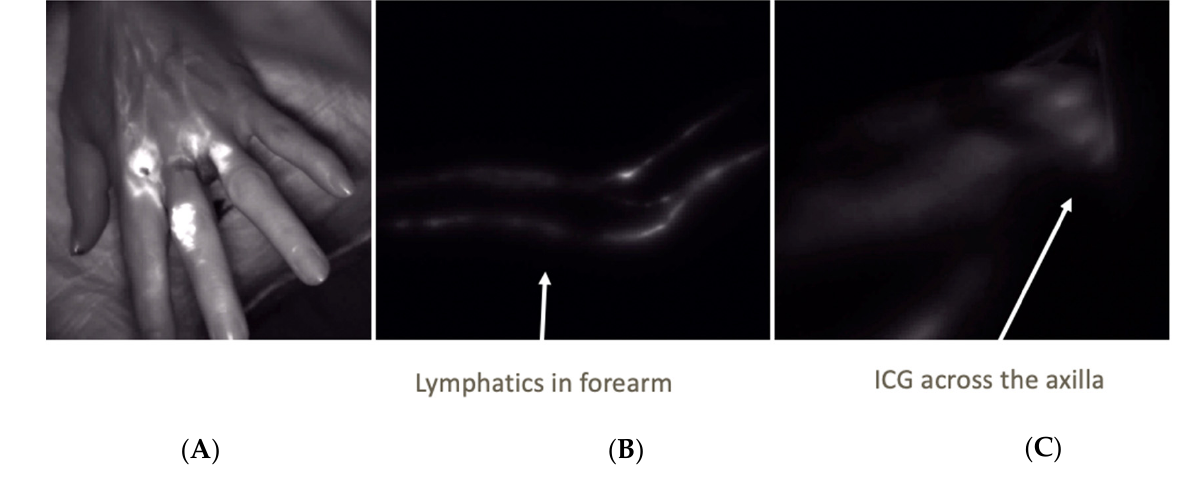
Figure 5. Lymphatic Mapping Postoperatively: ICG and SPY can be used postoperatively in clinic to assess patency of the anastomoses and evaluate lymphatic flow of the limb. ( A ) shows injection of ICG into the webspaces of the hand. The ICG is seen tracking proximally along the lymphatics across the forearm in ( B ). Eventually the ICG can be seen flowing across the axilla as in ( C ).